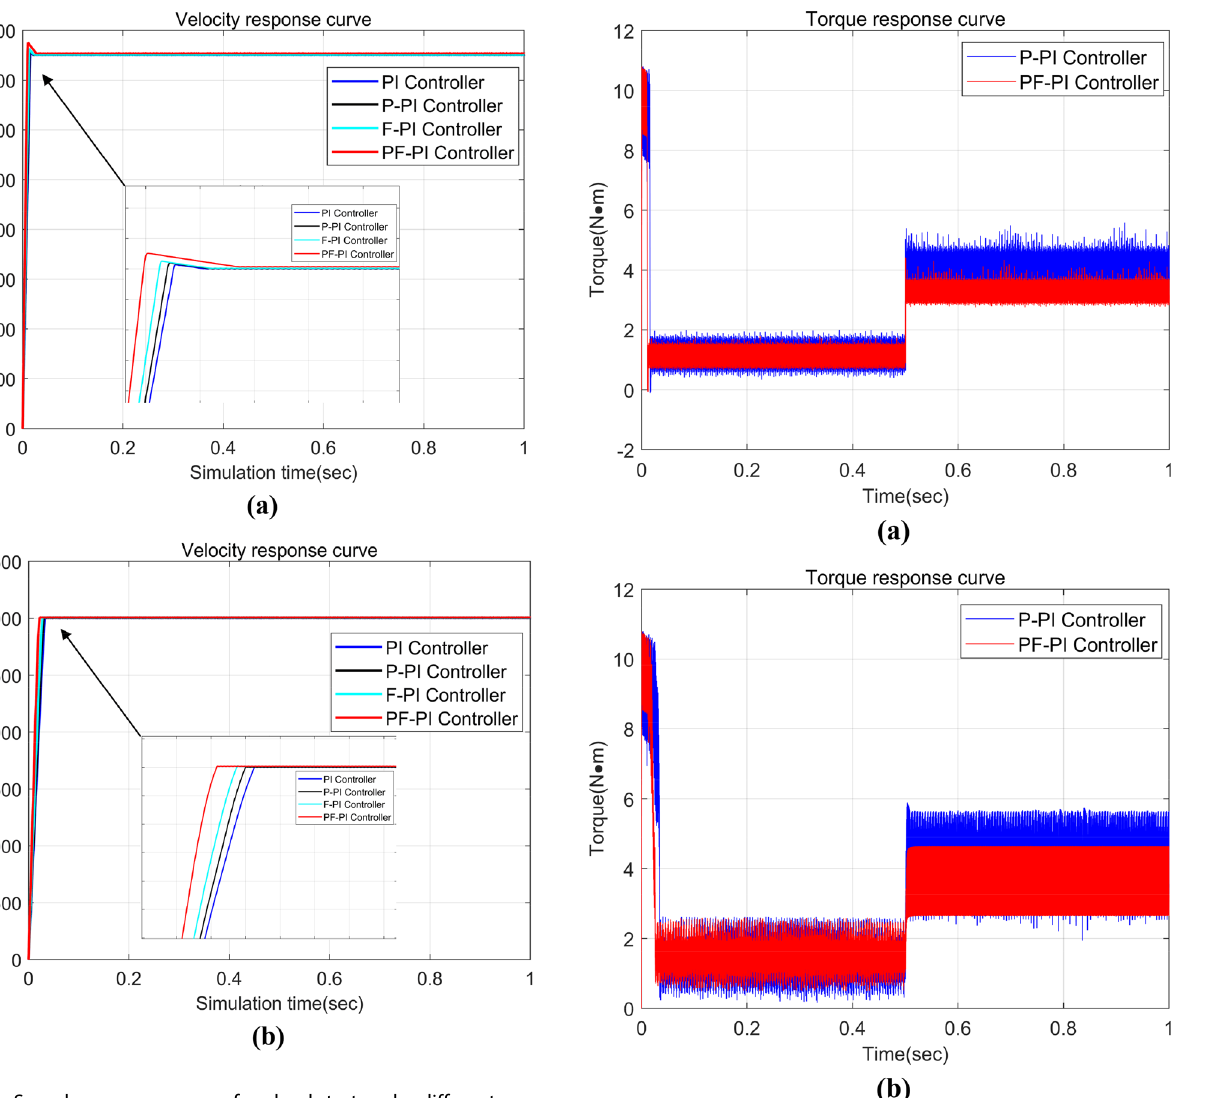
Fig. 17 Speed response curves of no-load start under different con- ditions a 0–1500 rpm and b 0–3000 rpm